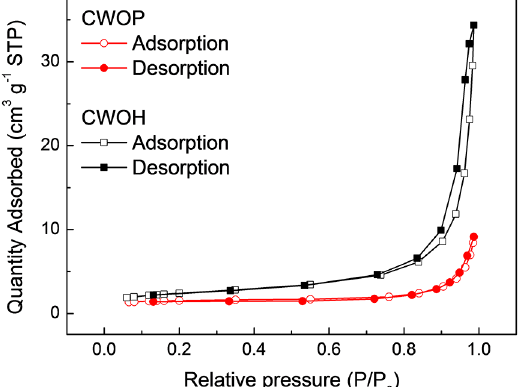
4 Figure 5. PL spectra of CaWO maximum emission peaks are centered on 492 nm and 495 nm